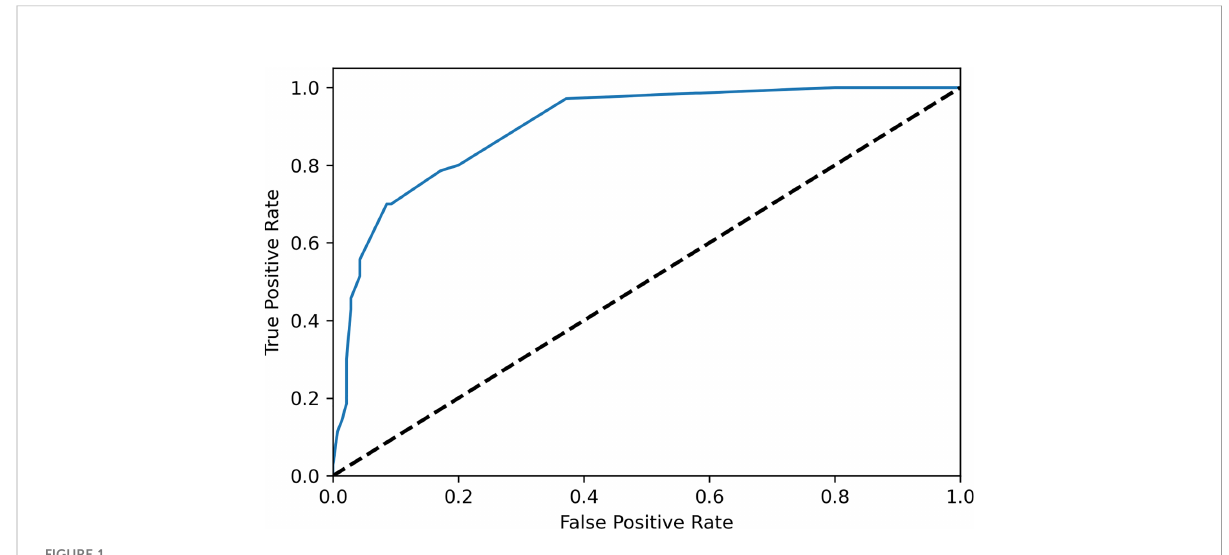
FIGURE 1 ROC curve of the scoring system was shown. The AUC was